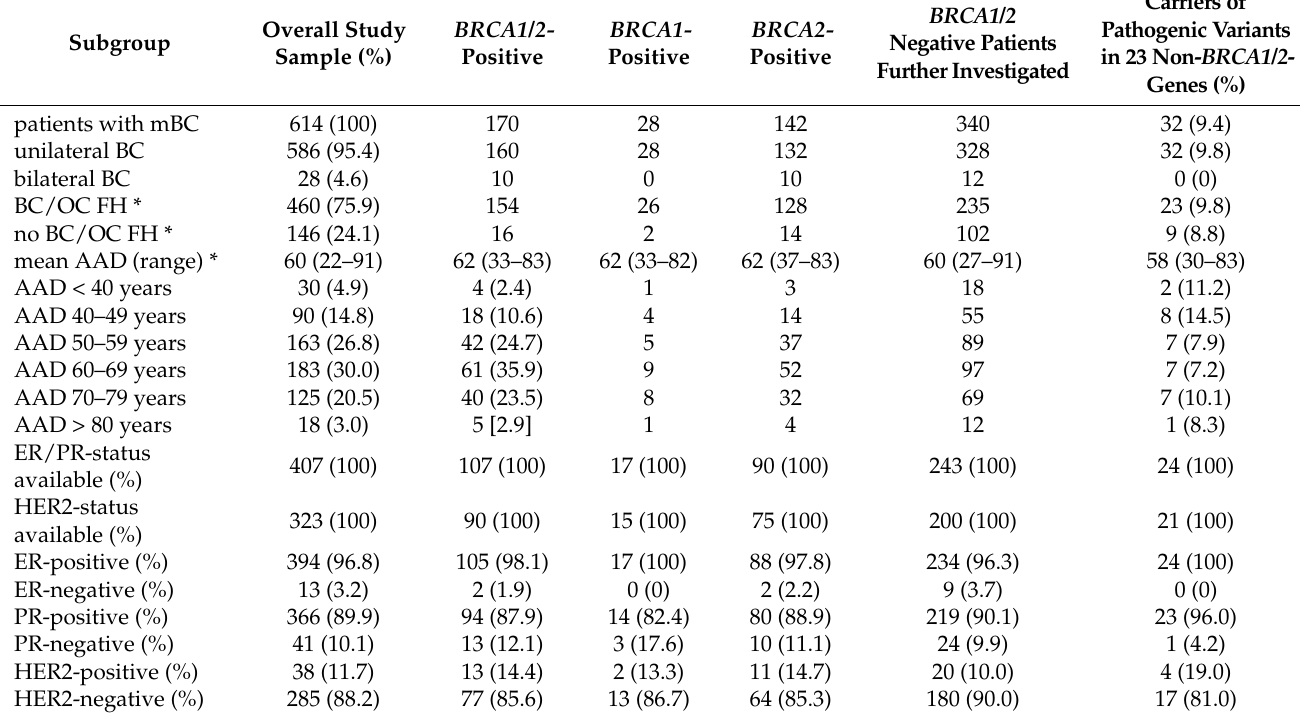
Table 1. Patient and cancer characteristics in the overall study sample (n = 614) stratified by pathogenic variant (PV) status, family history (FH), age at first diagnosis (AAD). BC = breast cancer, ER = estrogen receptor, mBC = male breast cancer, PR = progesterone